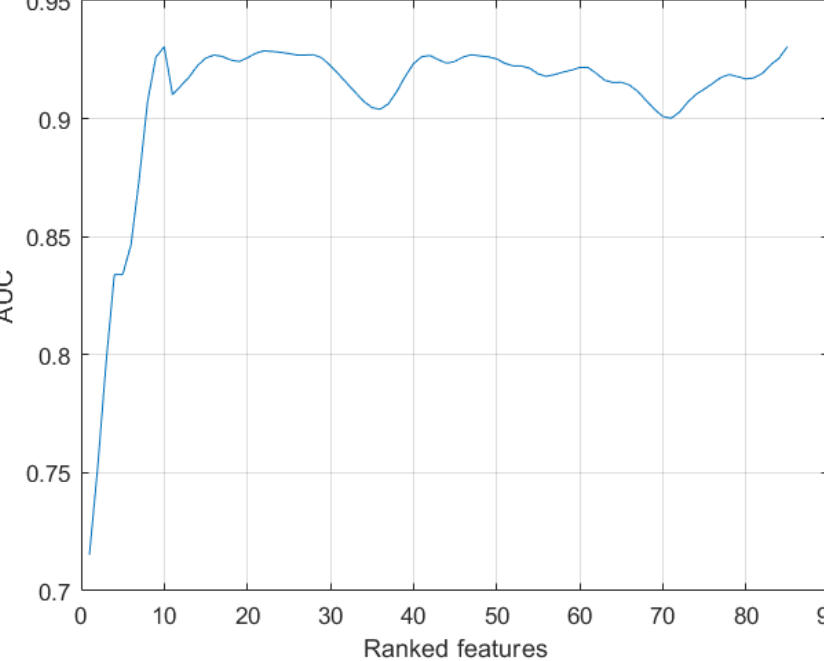
Figure 4. The first 10 ranked features of the RF classifier. In this study, a pattern of VOCs consisting of ketones, alkanes and methylate derivates, and hydrocarbons was found to be discriminate between MPM patients and healthy controls, with 93% accuracy. More specifically, as reported in Figure 4, the main VOCs identified as potentially diagnostics